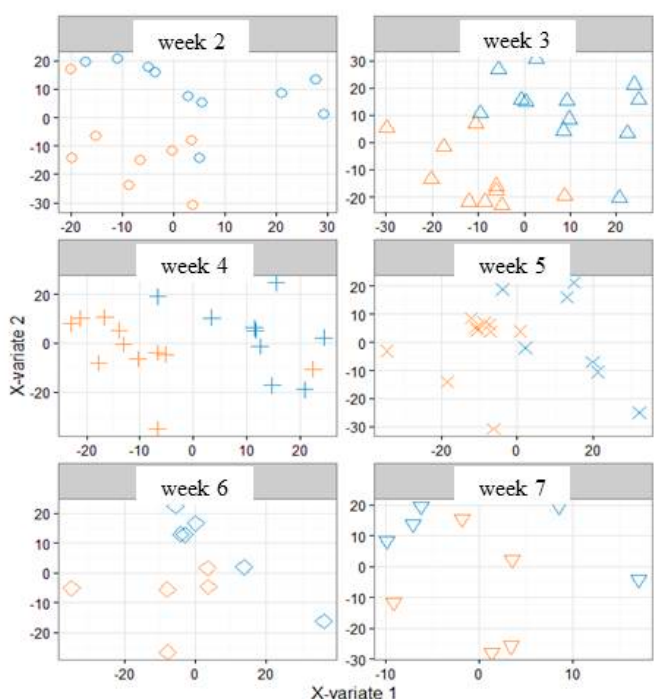
Figure 3. Multi-group PLS-DA score plots based on the LC-ESI + -HRMS profiles (3451 features, 118 milks) obtained on human preterm milk. Representation of the individuals: milk provided to preterm infants who experienced “faster” (orange) or “slower” (blue) growth from Week 2 to Week 7 of lactation. MB-PLS-DA score plots: ○ Week 2; ∆ Week 3; + Week 4; × Week 5; ◊ Week 6; ∇ Week 7. AoV-PLS (Step 2) was applied separately on the LC-HRMS (ESI + /ESI − ) to assess the association between the metabolites and the a priori grouping structure (“faster” vs. “slower” growth). The